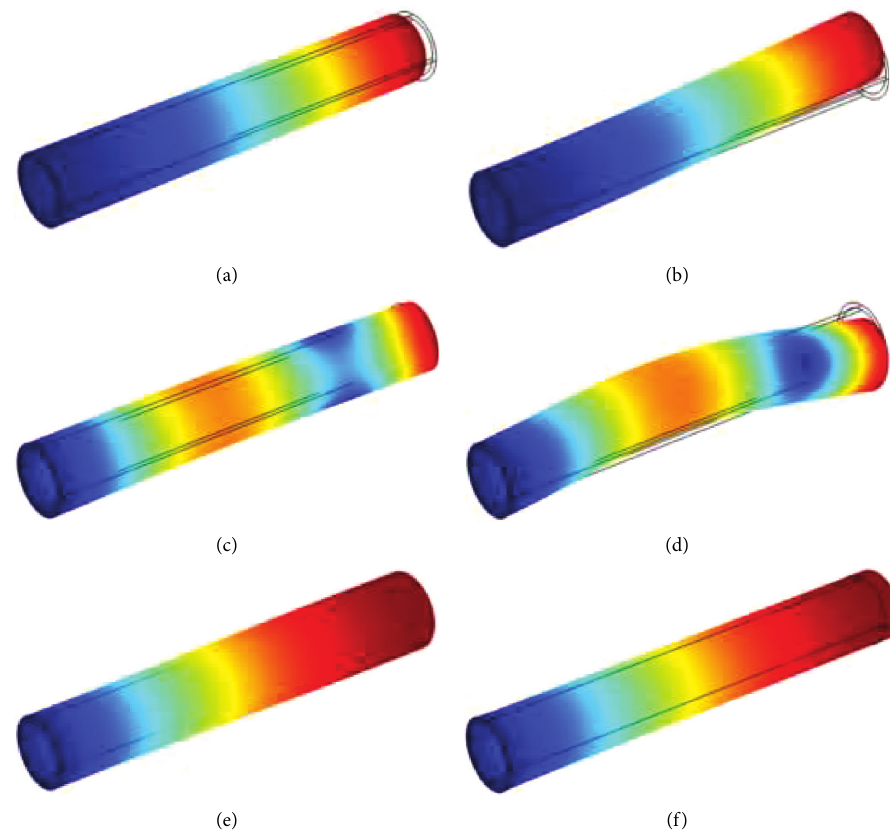
Figure 3: Fixed-free carbon nanotube fundamental frequency analysis for L/D ratio 7.2. (a) Fundamental frequencies F1, (b) F2, (c) F3, (d) F4, (e) F5, and (f)